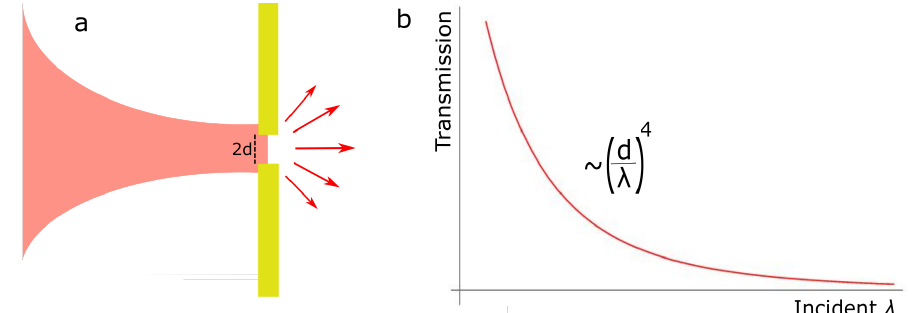
Figure 7. ( a ) Diffraction and transmission of visible light through a subwavelength circular hole of radius, d , on a perfectly conducting and infinitely thin metallic film. ( b ) According to Bethe’s calculation the transmission of incident light λ scales as ( d / λ ) 4 . Figure inspired by [59].